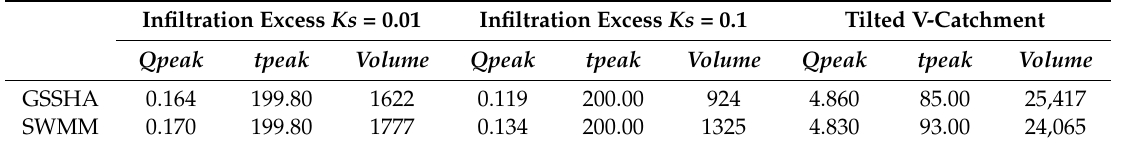
Figure 5. Outflow hydrograph response of the Infiltration Excess test case with two values of saturated hydraulic conductivity. Table 3. Summary metrics for benchmark cases by model.